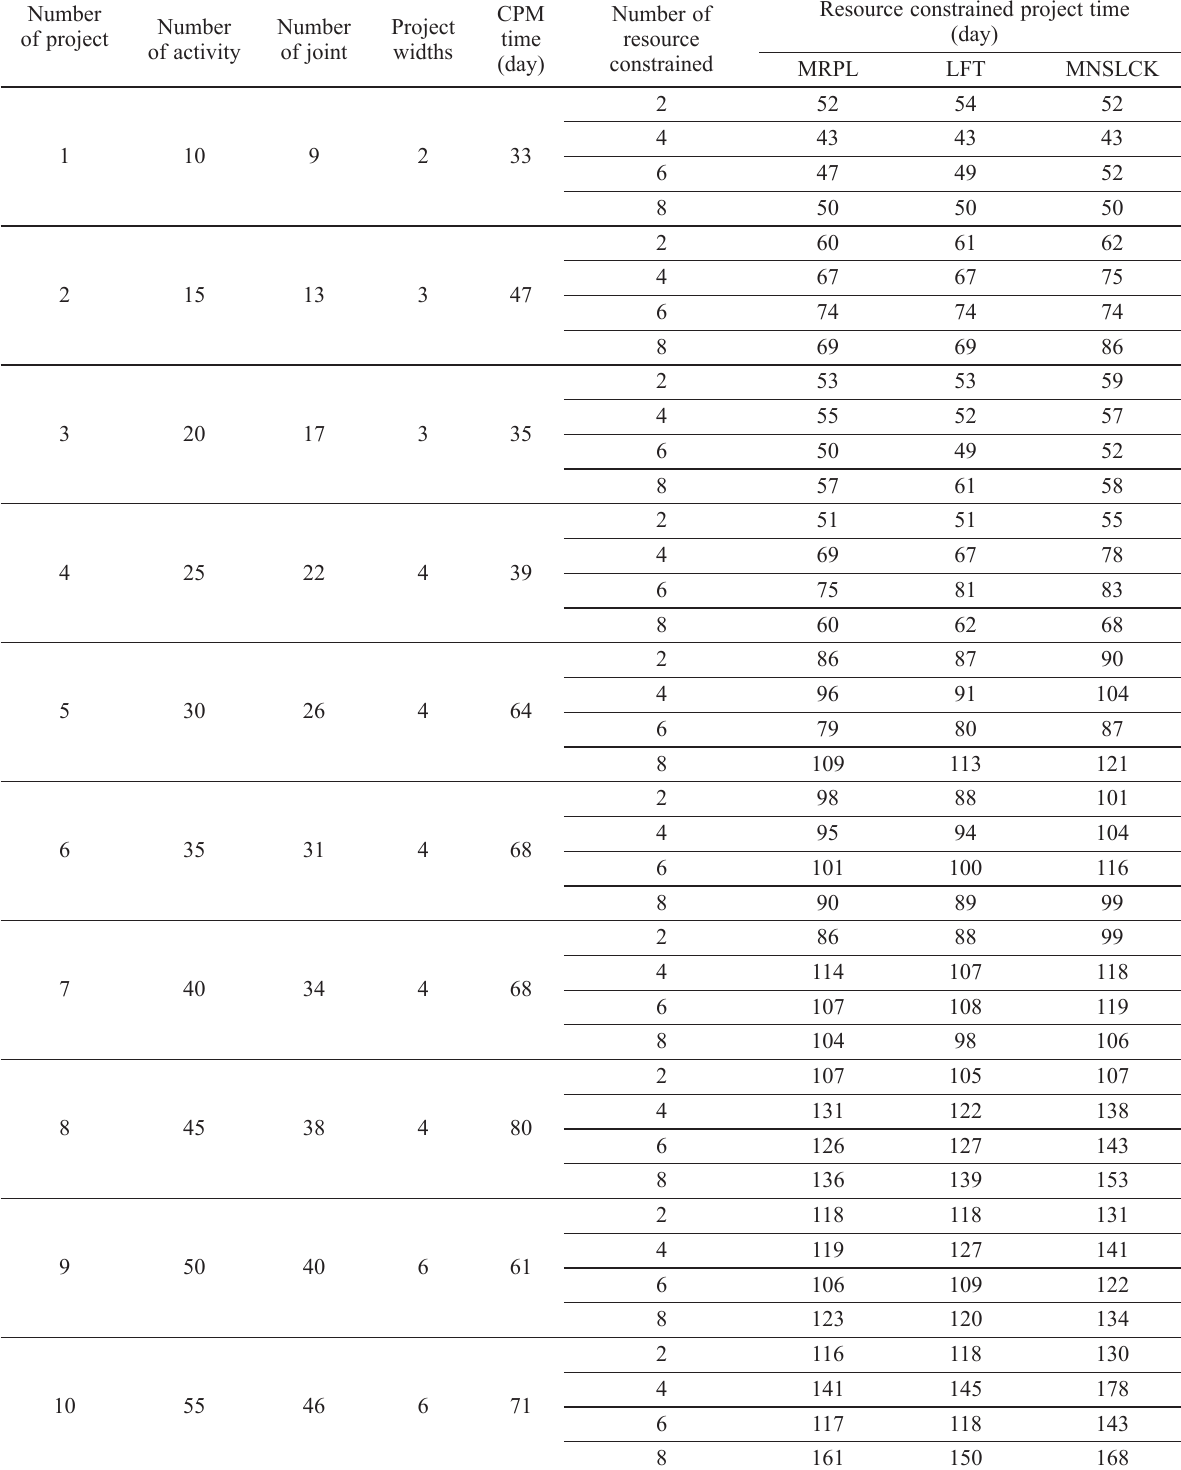
Table 1. Sample project (10 project)